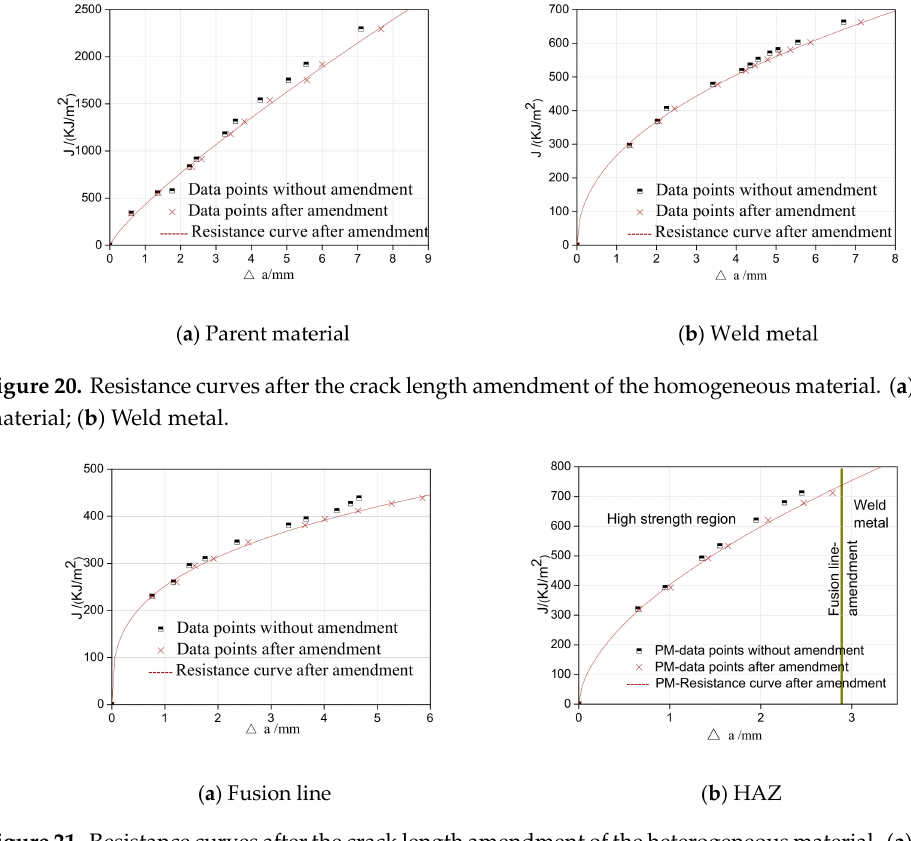
Figure 21. Resistance curves after the crack length amendment of the heterogeneous material. ( a ) Fusion line; ( b )